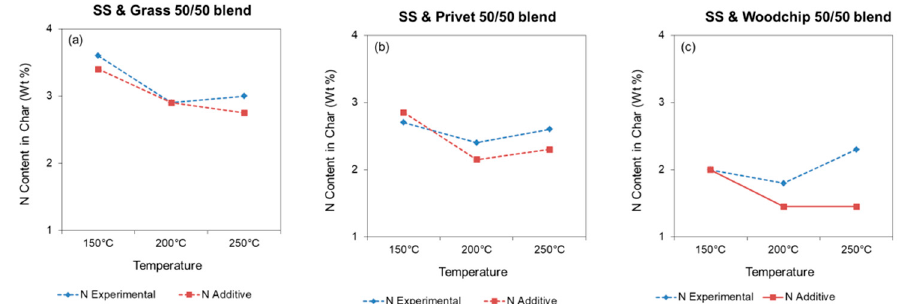
Figure 3. Comparison of experimental and additive nitrogen levels in the hydrochar from 50/50 blends for ( a ) SS and grass at 50/50 blend, ( b ) SS and privet hedge at 50/50 blend, and ( c ) SS and woodchip at 50/50 blend.